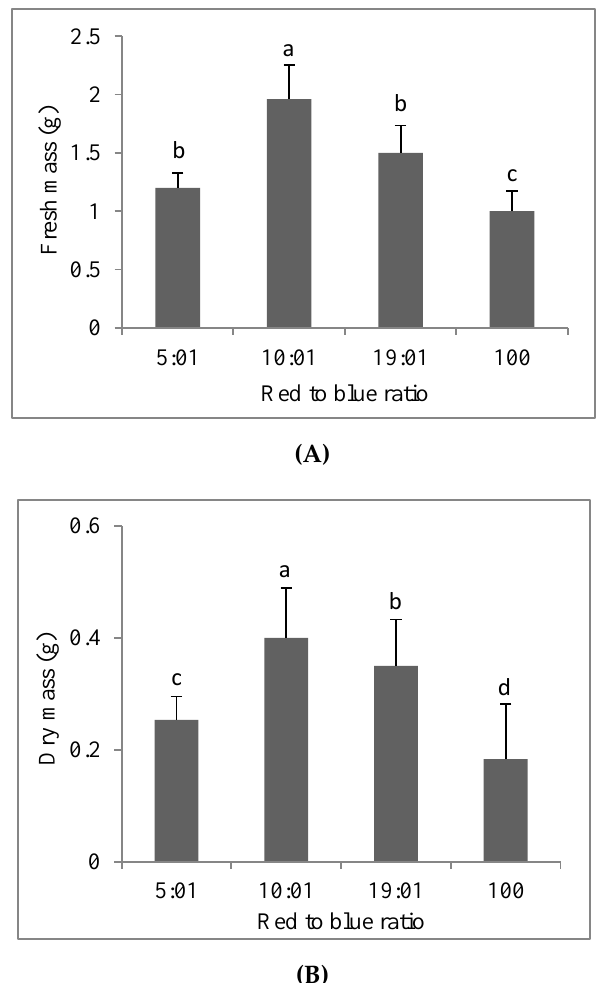
Figure 3. Fresh ( A ) and dry ( B ) mass of tomato plantlets under different ratios of red to blue LED light. Mean separation within columns by Tukey’s HSD tests ( n = 5). Values labeled with different letters in a column are significantly different ( p < 0.05).